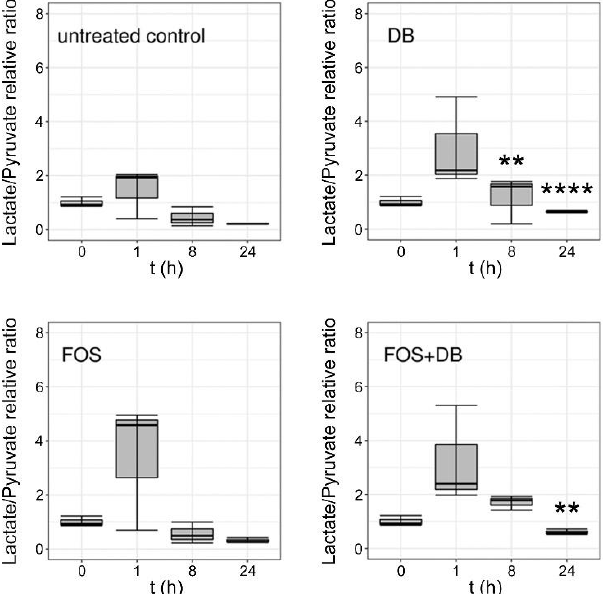
Figure 6. Relative lactate/pyruvate molar ratios in extracts at different times of P. falciparum cultures treated with 20 µM DB and fosmidomycin, individually and combined. **: p < 0.005; ****: p < 0.0001.